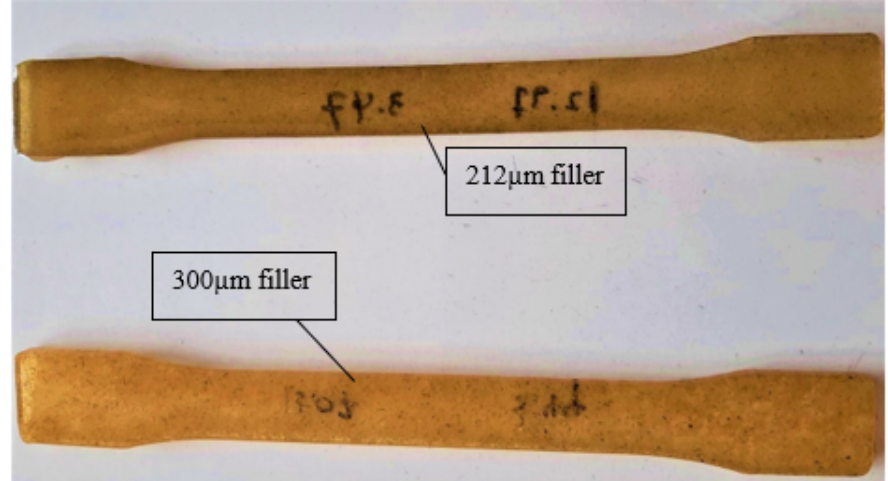
Figure 2. Tensile specimens of the baggage particle-reinforced composite: ≤ 212 µm and ≤ 300 µm filler.